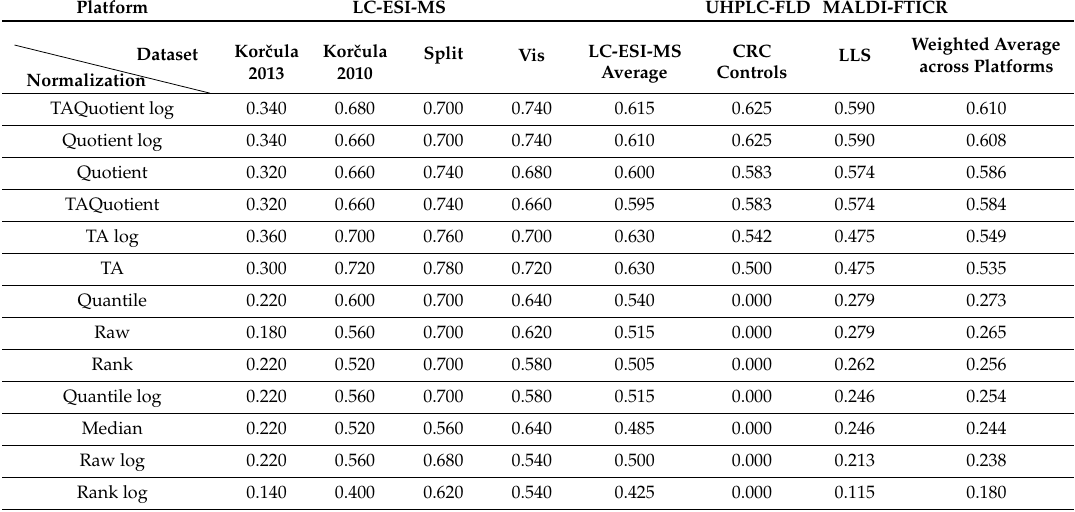
Table 3. Fraction of glycans significantly associated with age (False Discovery Rate 0.01). Normalization approaches are sorted by decreasing average fraction of significant